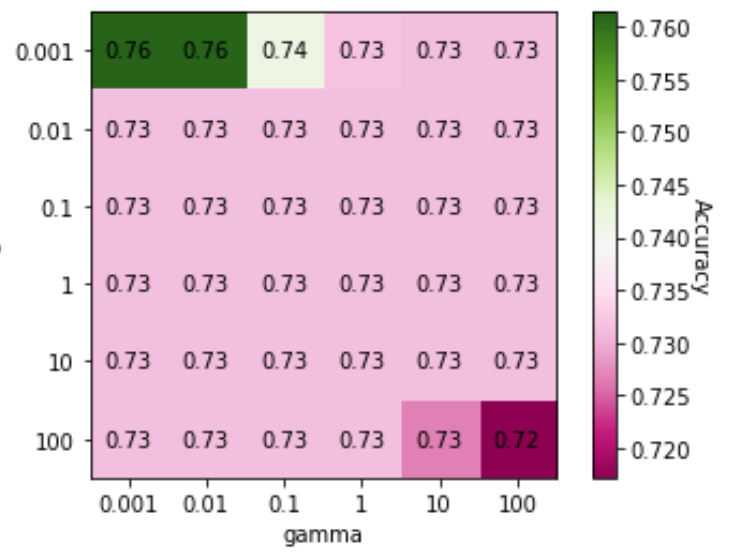
Figure 9. Heatmap of values of SVM parameters C and γ on Dataset 06 when classification was based on obesity.